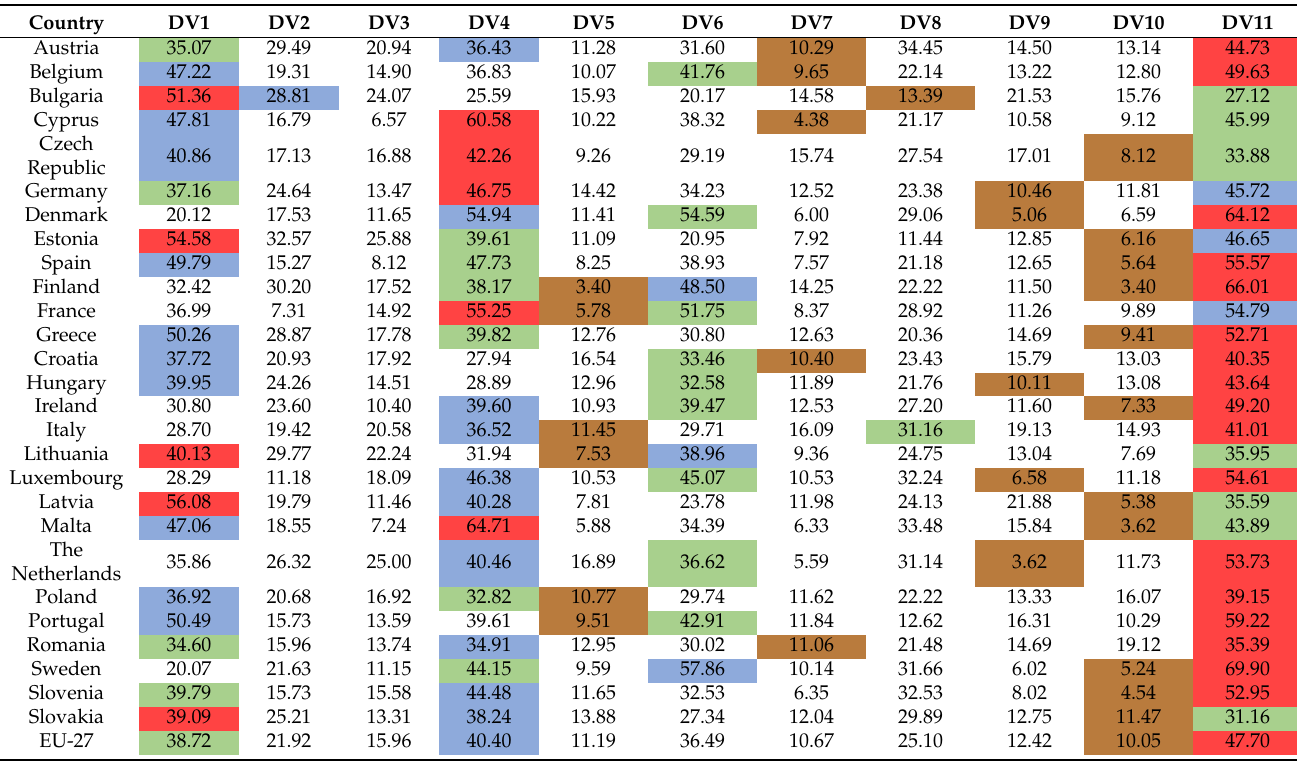
Table 3. Objectives to be given the highest priority in the European Energy Union according to respondents, in percent, by country.